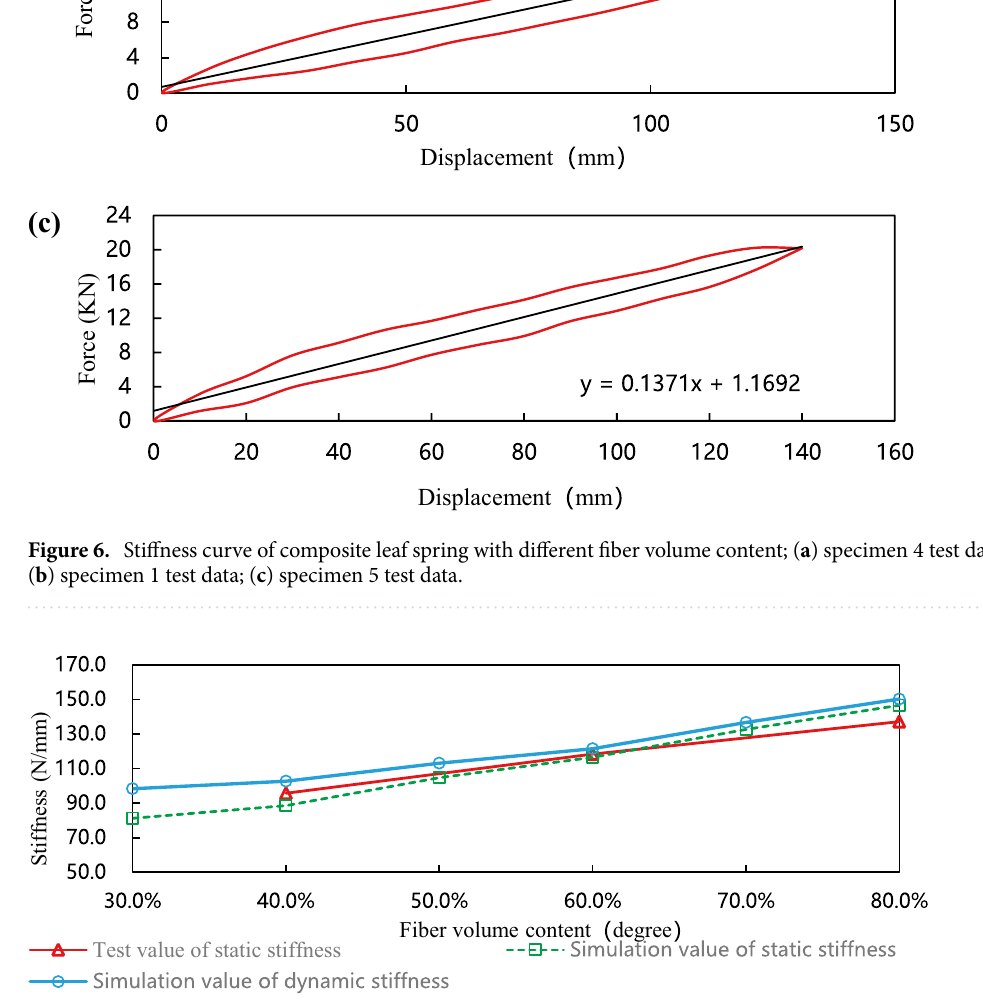
Figure 7. The simulation and experimental curves of leaf spring with different volume